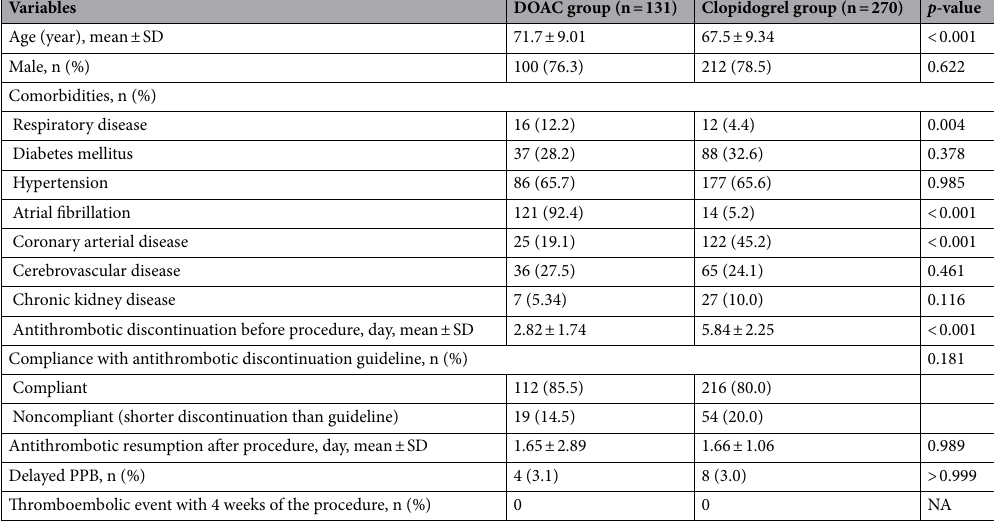
Table 1. Characteristics of patients who underwent colonoscopic polypectomy. DOAC Direct oral anticoagulant, SD standard deviation, PPB postpolypectomy bleeding, NA not